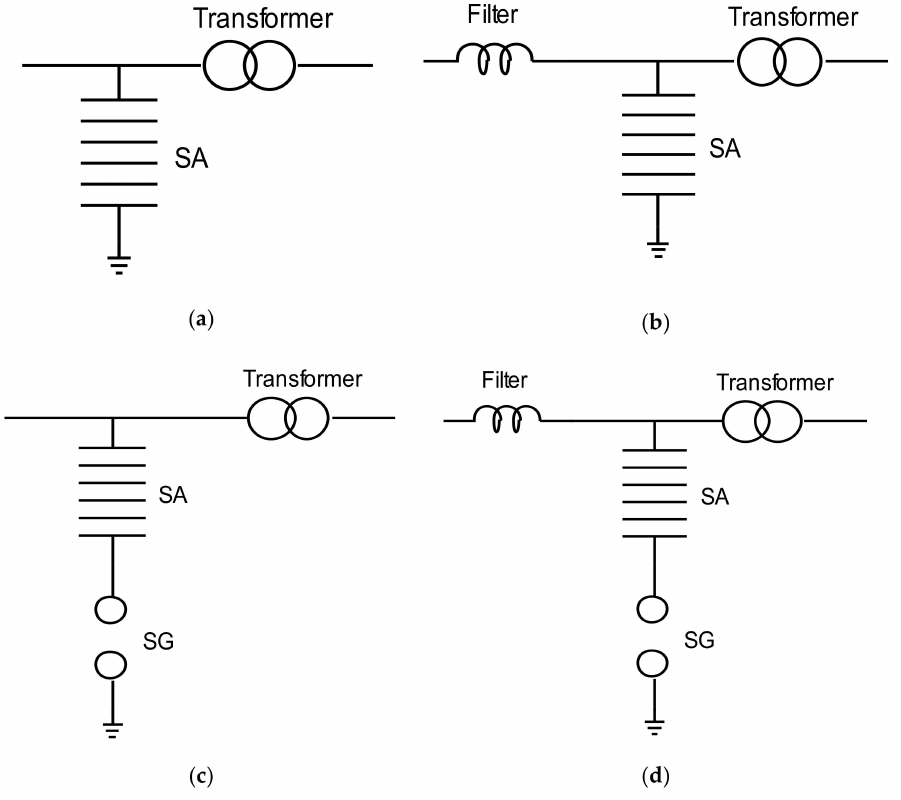
Figure 6. Lightning protection arrangement for MV transformers with ( a ) surge arrester, ( b ) filtered surge arrester, ( c ) joint surge arrester and spark gap, and ( d ) filtered surge arrester and spark